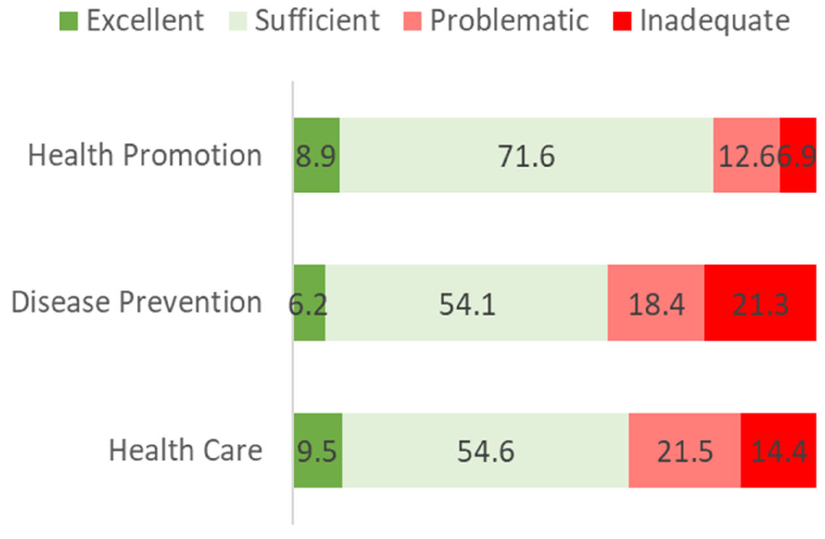
Figure 2. Dimensions of health literacy (%)